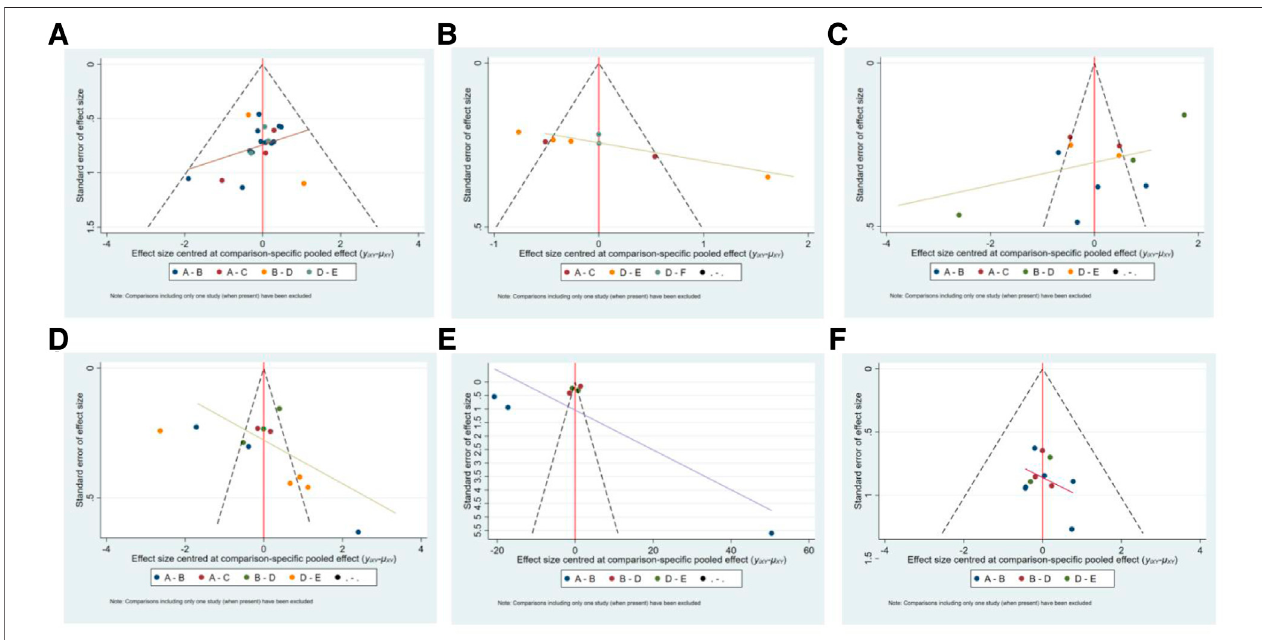
FIGURE 7 | The funnel plot of outcome indicators. A :effectiveness rate; B :CK; C :CK-MB; D :LDH; E :cTnI; F :adverse reaction rate. A: conventional treatment; B: conventional treatment + trimetazidine + Astragalus injection; C: conventional treatment + trimetazidine + Shenfu injection; D: conventional treatment + trimetazidine; E: conventional treatment + trimetazidine + Salviae miltiorrhizae and ligustrazine hydrochloride injection; F: conventional treatment + trimetazidine + Beviscapine injection.